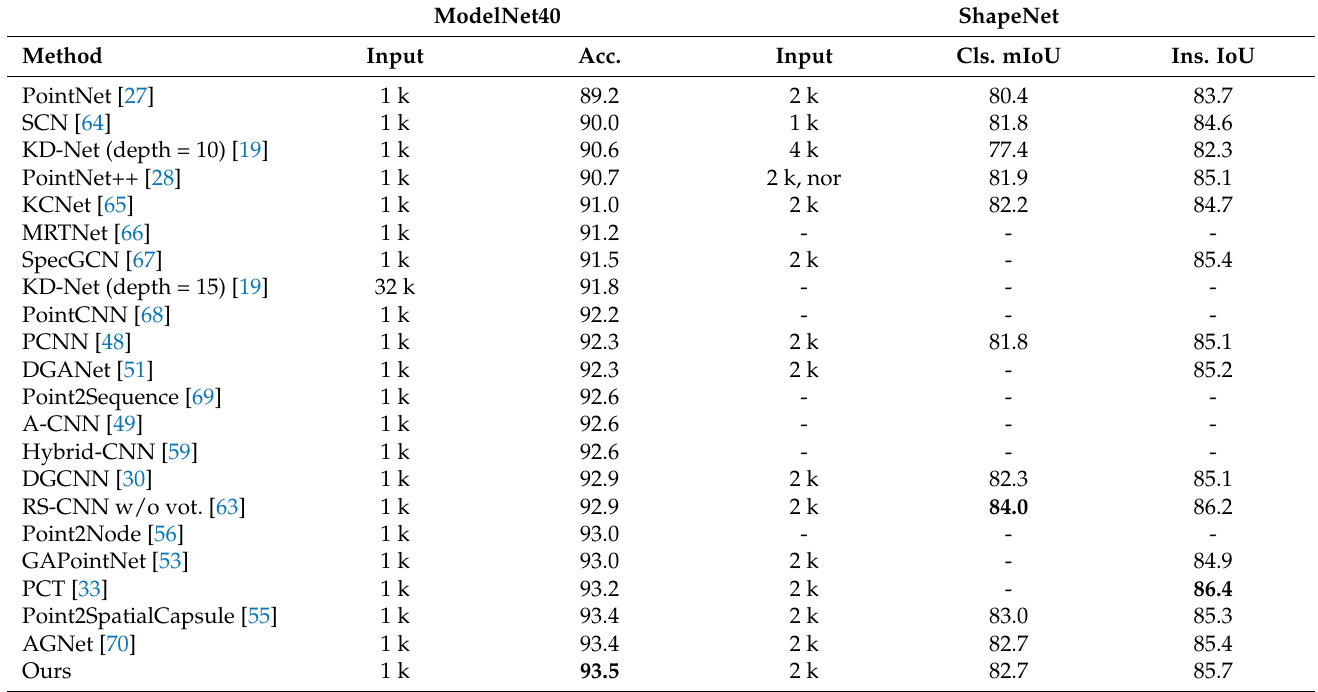
Table 1. Shape classification and part segmentation results (%) (“nor”: normal; “-”: unknown; “k”: 1024). The best scores in the table are marked in bold